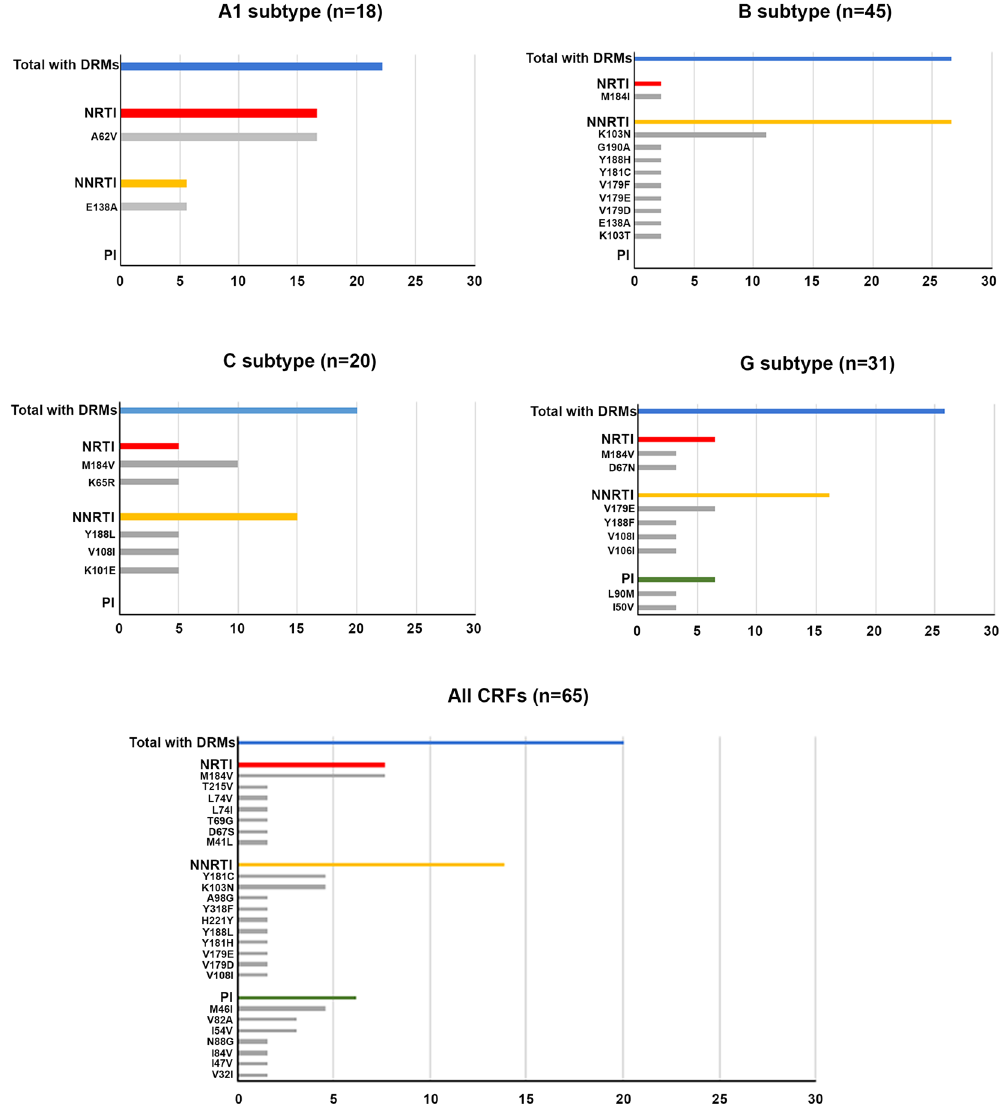
in the analysis is indicated in brackets at the top of each clade. Blue bar: total frequency of DRMs; red bar: frequency of DRMs to NRTIs; yellow bar: frequency of DRMs to NNRTIs; green bar: frequency of DRMs to PIs; grey bar: frequency of each single